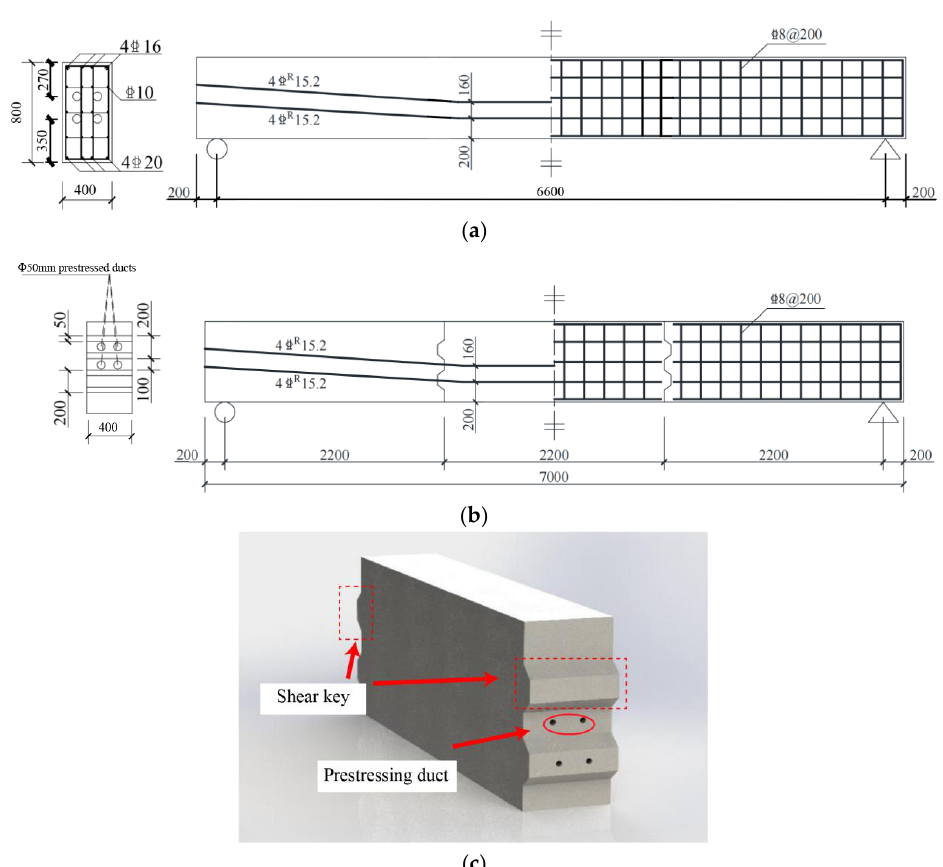
Figure 1. Reinforcement design and dimension of precast segmental beams and cast-in-place concrete beams: ( a ) cast-in-place beams; ( b ) precast segmental beams; ( c ) schematic diagram of a segment.